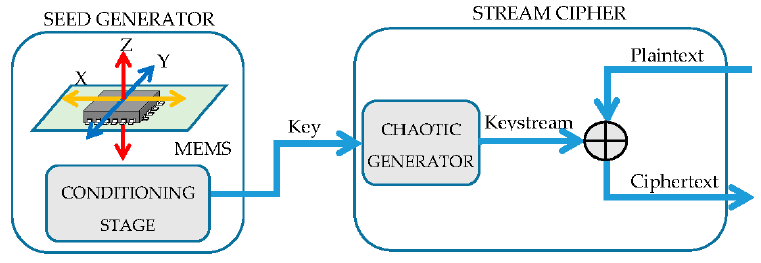
Figure 1. Overview of the full cryptosystem, including a chaos-based stream cipher and a sensor-based seed generator.